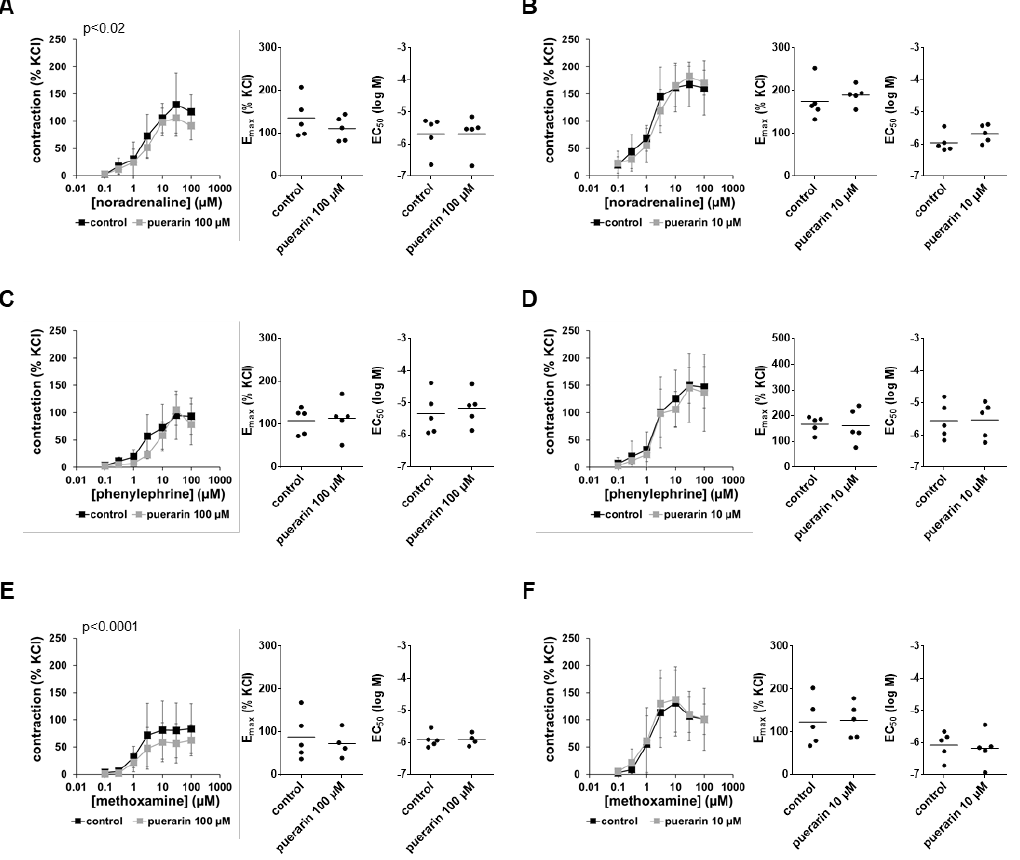
Figure 6. Effects of puerarin on α 1 -adrenergic contractions of human prostate tissues. Contractions were induced by the α 1 -adrenergic agonists noradrenaline ( A , B ), phenylephrine ( C , D ) and methox- amine ( E , F ) in the presence of 100 µM puerarin ( A , C , E ), 10 µM puerarin ( B , D , F ) and corresponding amounts of solvent (methanol) for the controls added 30 min before the construction of concentra- tion – response curves. Data from experiments with tissues from n = 5 patients are shown in each diagram. In each experiment, tissue from one patient was allocated to the control and puerarin groups. Data are means ± SDs in concentration – response curves ( p -values for whole groups from two-way ANOVA), and E max and EC 50 values are from all single experiments (calculated by curve fitting) in scatter plots ( p -values from two-tailed t -tests).